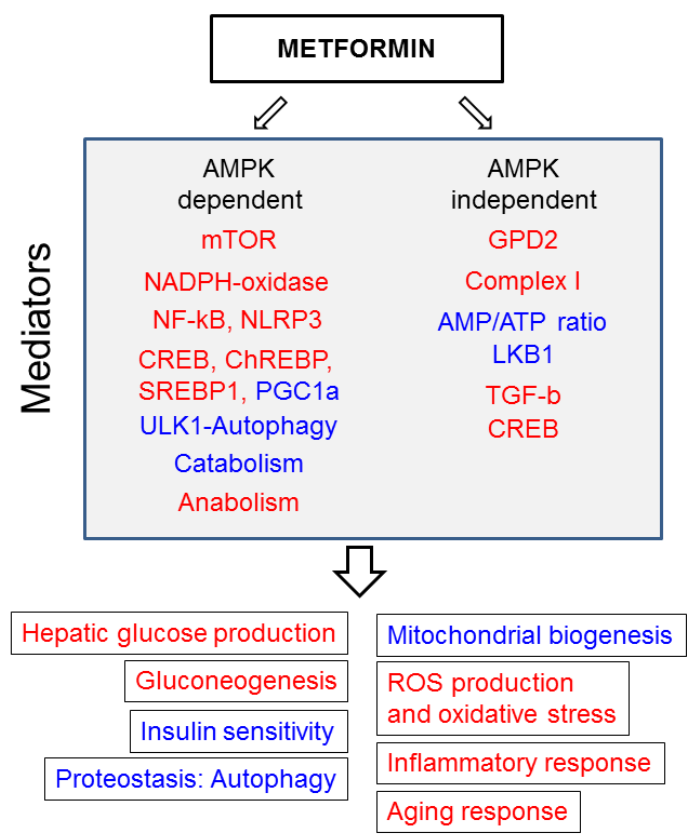
Figure 2. Mechanisms of action of metformin and cellular outcomes. Proteins affected by metformin, either via AMPK-dependent and AMPK-independent pathways, are indicated. In red are outcomes that are inhibited by metformin. In blue are those that are enhanced by metformin.